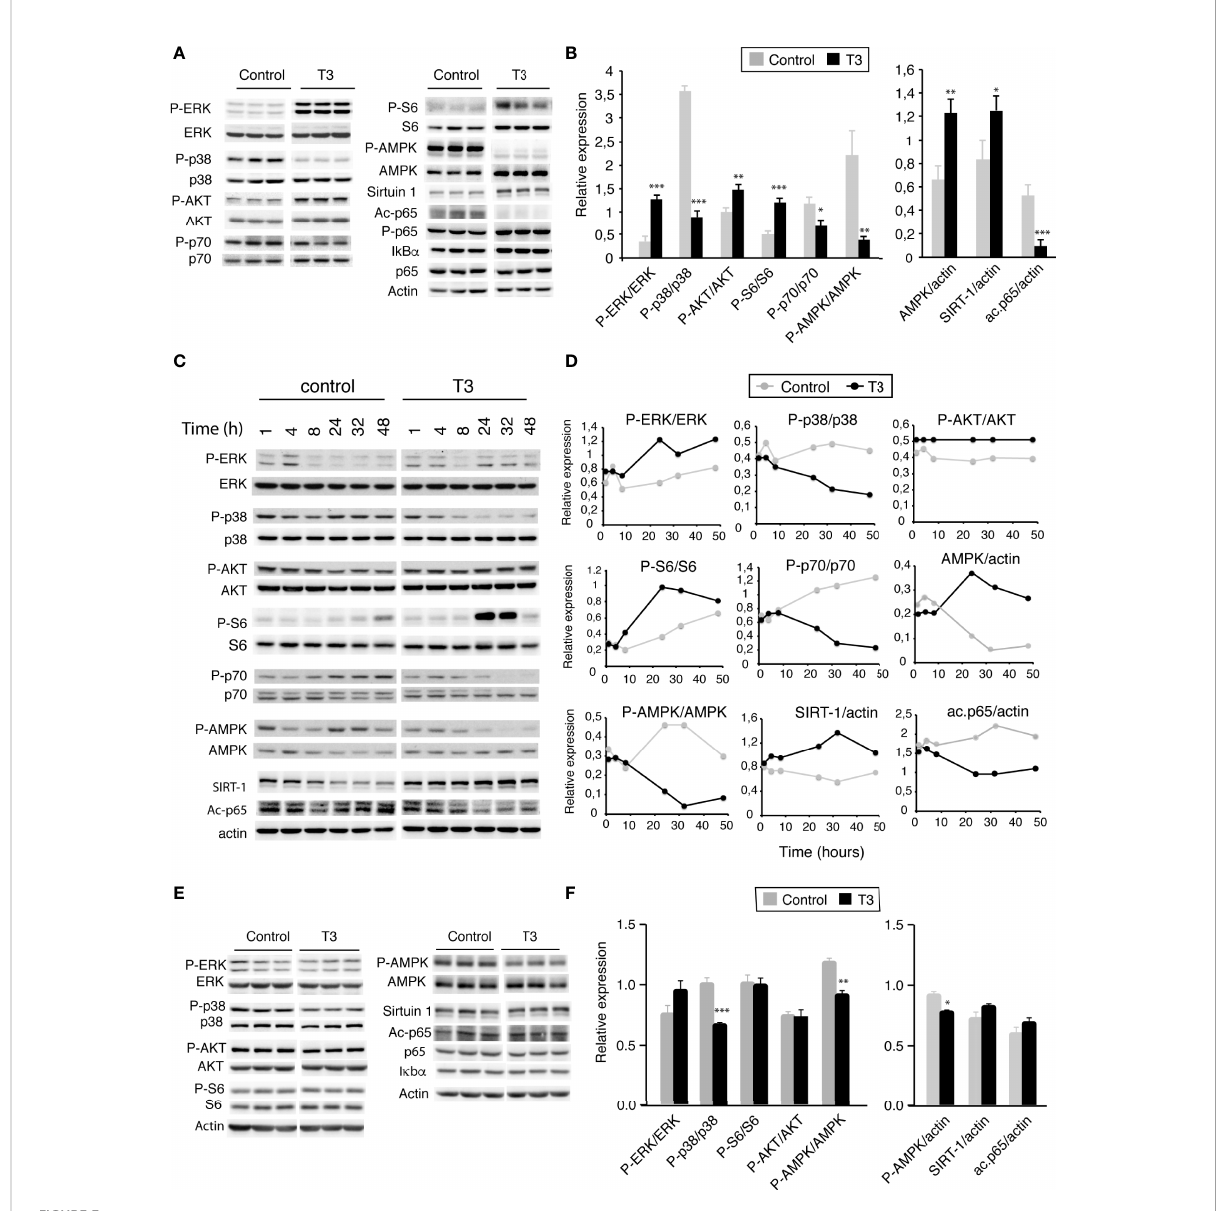
FIGURE 3 T3 alters activity of key signaling pathways that control metabolism, viability and proliferation. (A) I-BMDM plated in complete medium were shifted to hormone-depleted medium after 5 h and incubated with and without 10 nm T3 for 48h. Representative western blot analysis with the indicated antibodies are shown. (B) Quanti fi cation from 6 independent experiments showing relative values of phosphorylated versus total proteins or relative to actin levels used as a loading control. (C) I-BMDM plated in complete medium were shifted to depleted medium and after 5 h incubated with and without 10 nM T3 for indicated time periods, ranging between 1 and 48h. Representative western blots with the indicated antibodies are shown. (D) Quanti fi cation of western blots from two independent experiments with variations lower than 20%. (E) Primary cultures of BMDM (P-BMDM) differentiated for 5 days in complete medium were shifted to hormone-depleted medium and incubated in the absence (control) and presence of 10 nM T3 for 48 h. Representative western blot analysis with the indicated antibodies are shown. (F) Quanti fi cation of the western blots from 6 independent experiments in control and T3-treated cells showing relative values of phosphorylated versus total proteins or values relative to actin levels used as a loading control. Data are means ± SD. *p < 0.05, **p < 0.01, ***p <